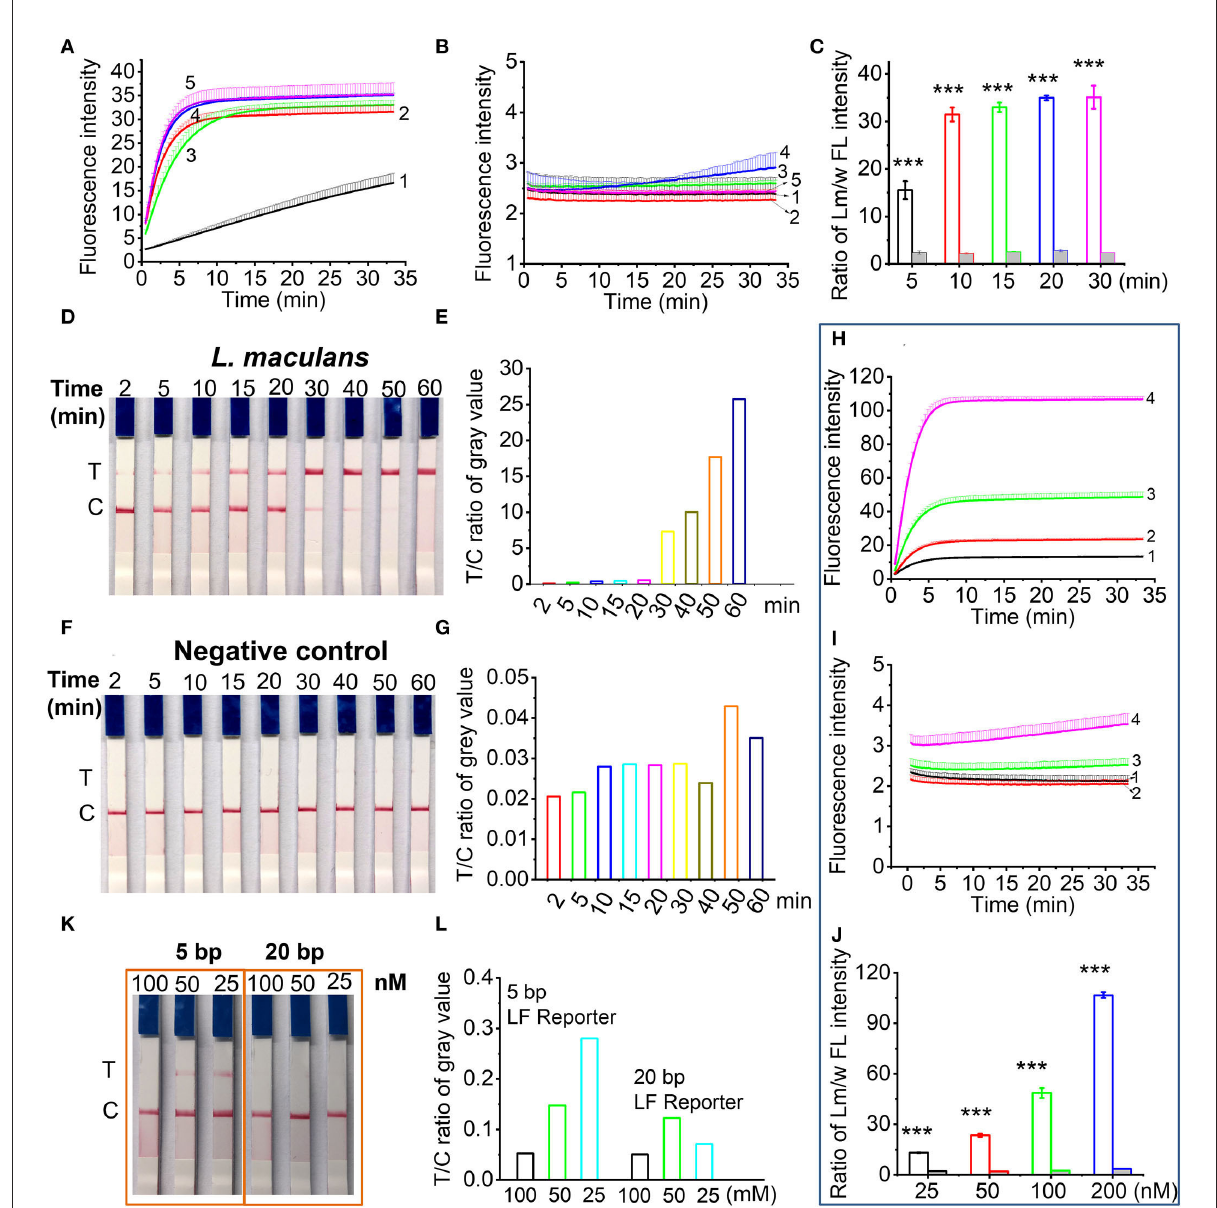
FIGURE3 Optimization of RPA/Cas12a-based nucleic acid detection. (A,B) Real-time fluorescence signals of RPA products from L. maculans (A) and water (B) with different RPA reaction time. Line 1-5 indicated the RPA products with RPA time of 5, 10, 15, 20, and 30min, respectively. (C) The ratio of fluorescence intensity (FI) between L. maculans and water at 30-min CRISPR reaction. (D) Lateral flow assay of L. maculans with different Cas12a/crRNA reaction time from 2 to 60min, respectively. (E) The ratio of gray value between T line and C line of lateral flow strips in (D) . (F) Lateral flow assay of negative control (water). (G) The ratio of gray value between T line and C line of lateral flow strips in (F) . (H,I) Real-time fluorescence signals of RPA products of L. maculans (H) and water as the negative control (I) with different FL reporter concentrations. Line 1-4 indicated the concentration of FL reporter is 25, 50, 100, and 200nM, respectively. (J) The ratio of fluorescence intensity between L. maculans and water at 30-min CRISPR reaction. (K) Lateral flow assay of 5 bp and 20 bp LF reporter with different concentrations. (L) The ratio of gray value between T line and C line of lateral flow strips in (K) . The data of ratio between Lm/w FL intensity are presented as the mean ± SD from three independent experiments. *** indicates p < 0.001.